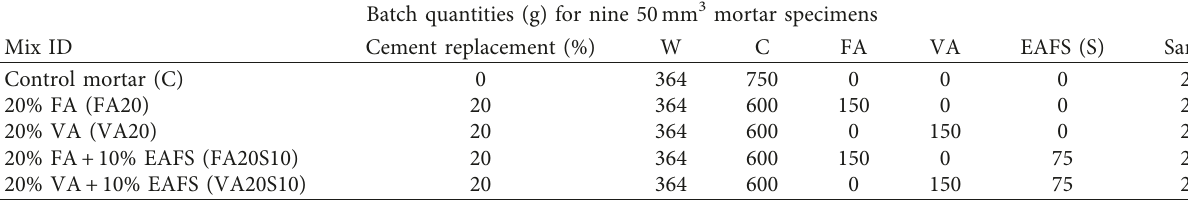
Table 3: Mixture proportions of mortar (w/cm